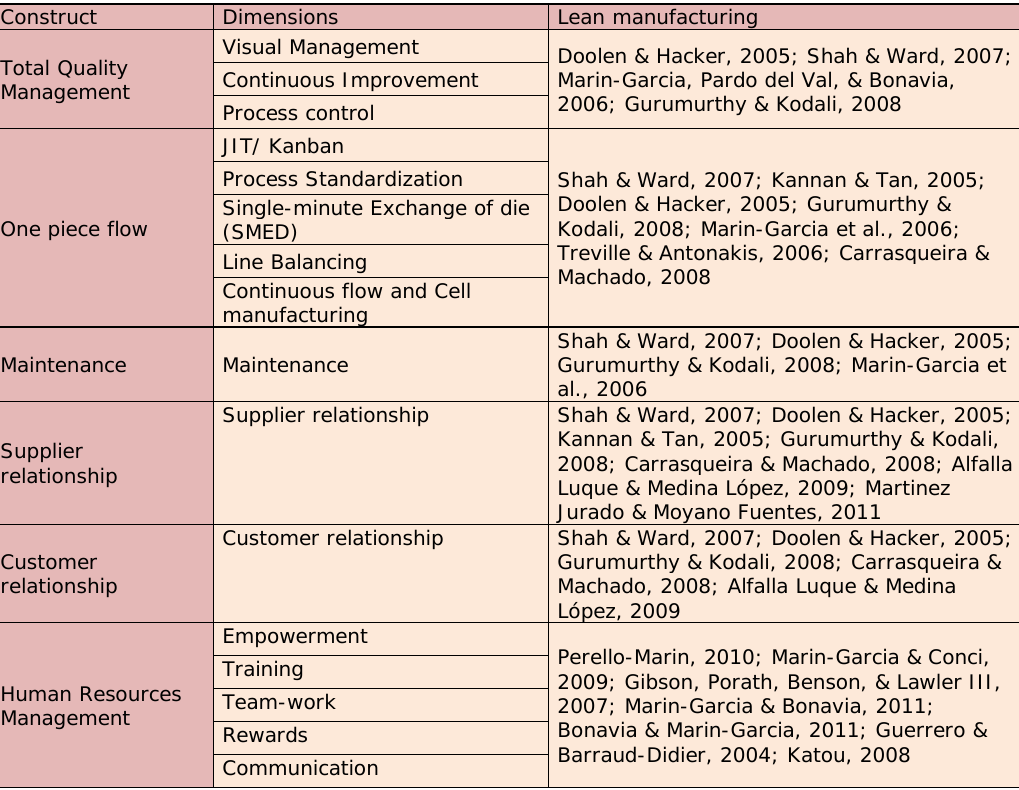
Table 1. Constructs and dimensions of alternative tools to mass manufacturing included